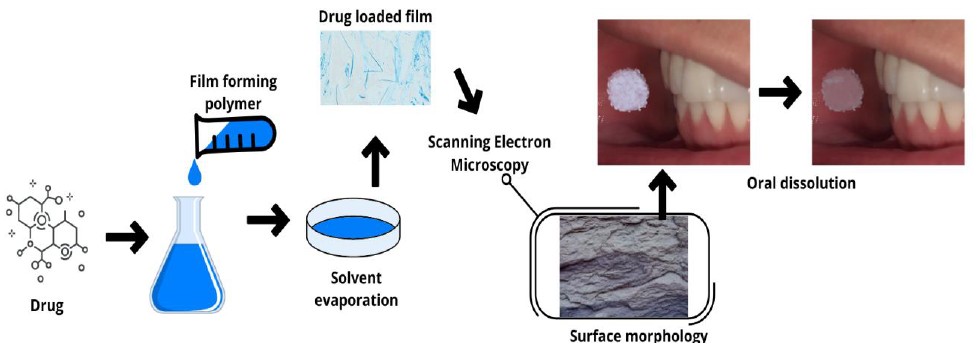
Figure 2. Schematic representation of film production by the casting technique until its application in the mouth, and its dissolution.